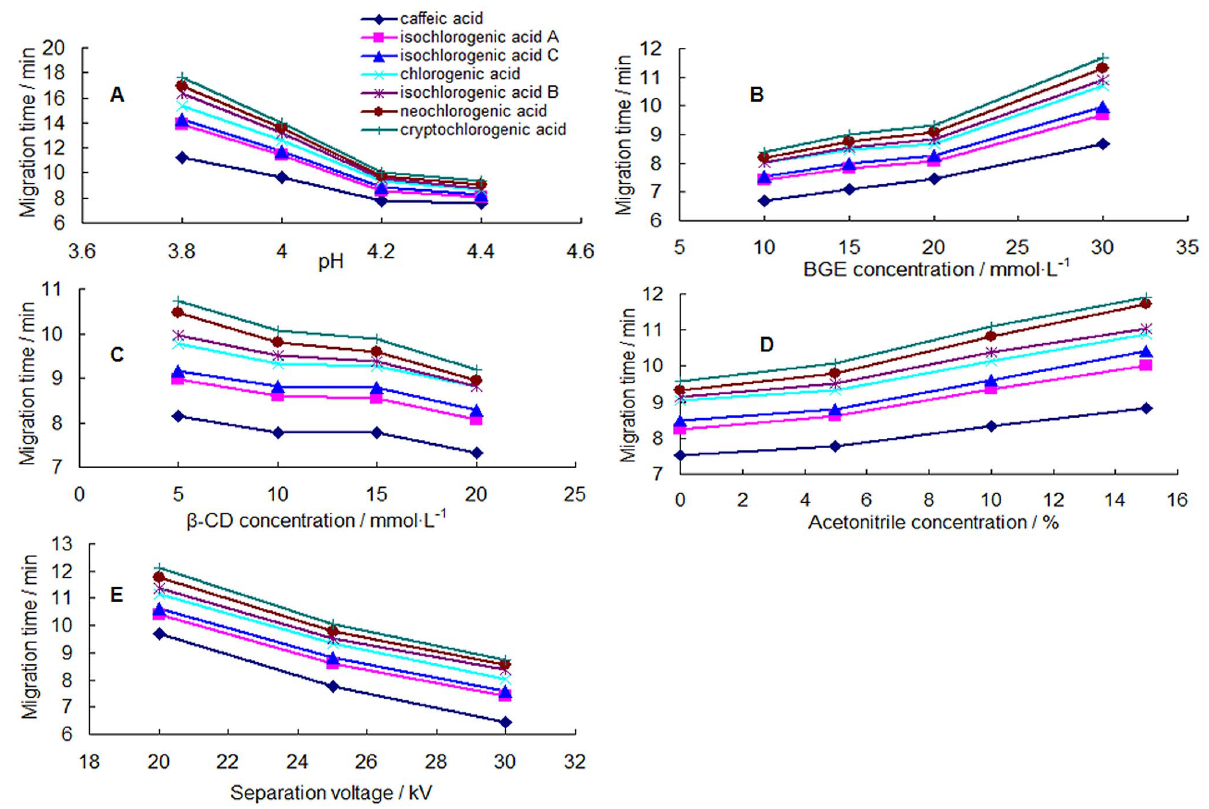
Figure 2. Effects of parameters on the migration time and resolution of seven peaks (n=3). (A) pH of the phosphate buffer, (B) BGE concentration, (C) b -CD concentration, (D) acetonitrile concentration, (E) separation voltage.